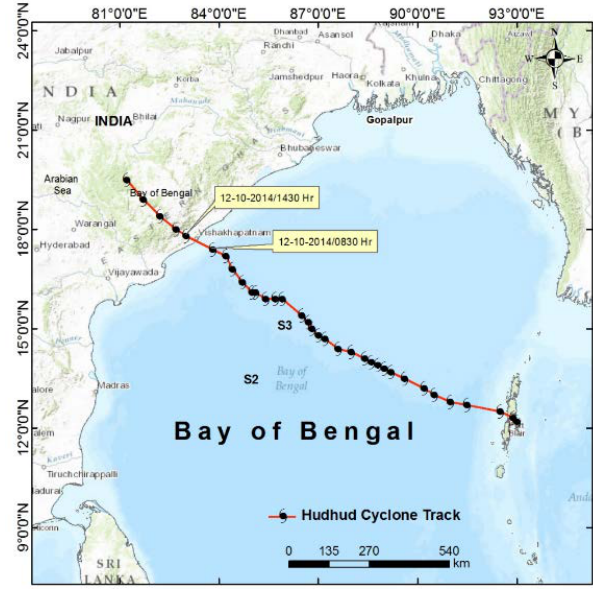
Figure 2. Cyclone track map